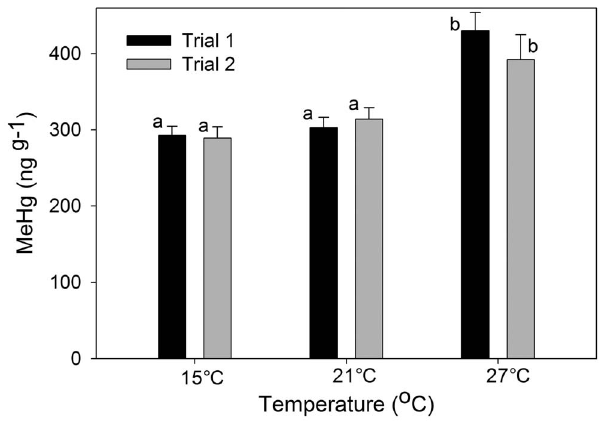
Figure 5. Mean 6 s.d. of growth (expressed as % weight change) of killifish exposed to 15 6 C, 21 6 C and 27 6 C for 30 days. Trial 1 killifish had positive growth in all treatment temperatures. Trial 2 killifish had slight negative average growth in treatment temperatures of 15 u C and 27 u C.